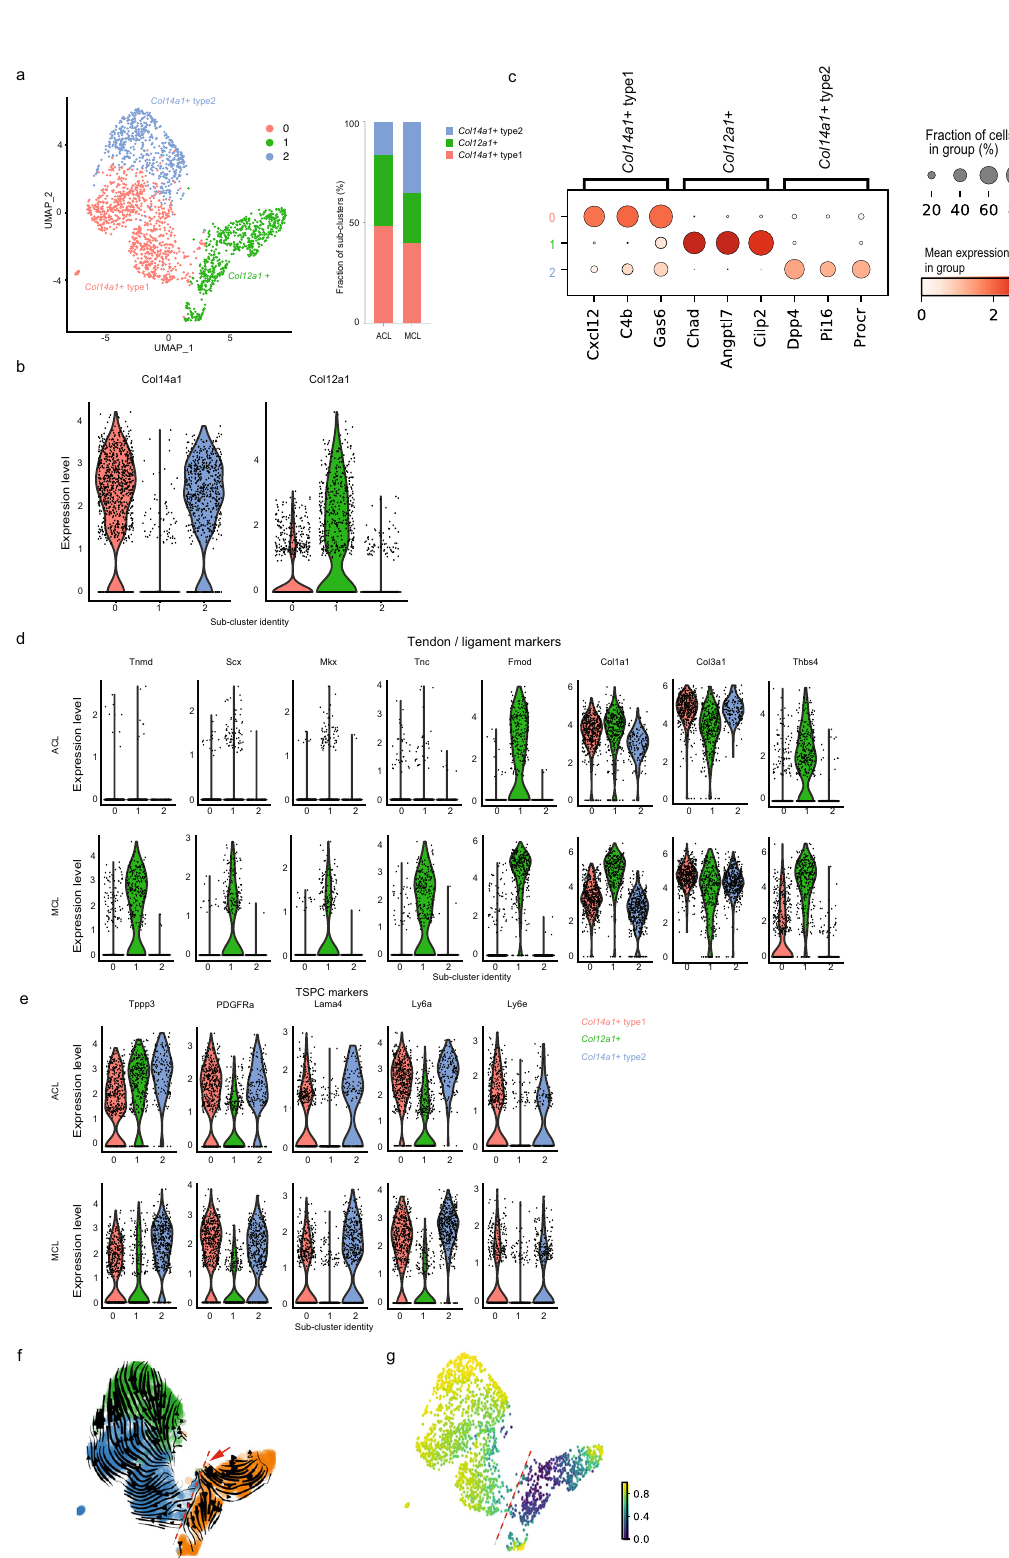
COMMUNICATIONS BIOLOGY| (2022) 5:1233